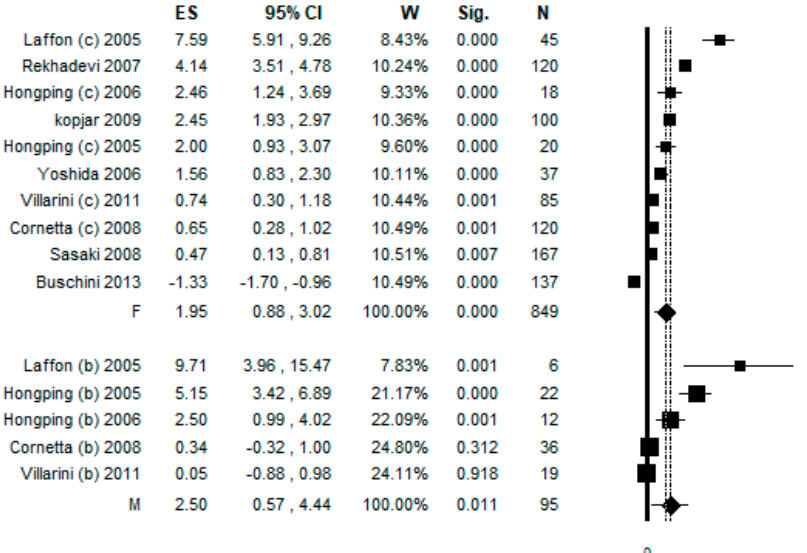
Figure 5. Forest plot of the sub-group analysis by gender assessing the comet assay on lymphocytes cells among professionals occupationally exposed to antineoplastic drugs (ANDs). F, female, M, male.